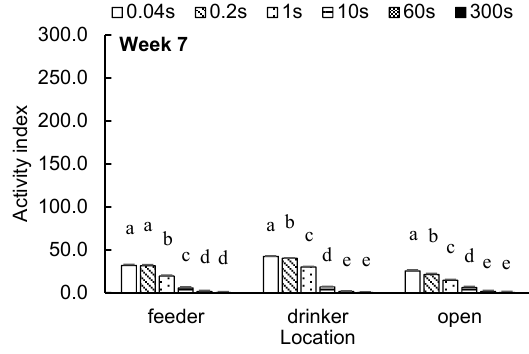
Figure 2. Weekly average broiler activity index (least square means ± SEM) at feeder, drinker and open areas with different time intervals. a,b,c,d,e Means with different superscripts within the same category are different ( p < 0.05).